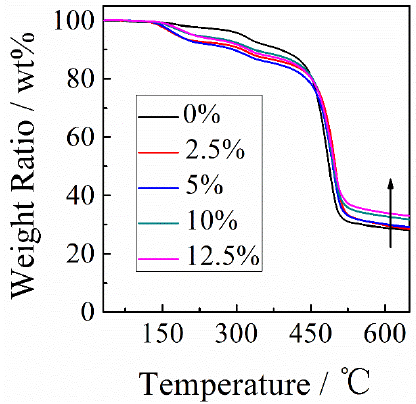
Figure 6. Thermogravimetric analysis curves of PAI/PANI/CB ternary composites with different compositions.